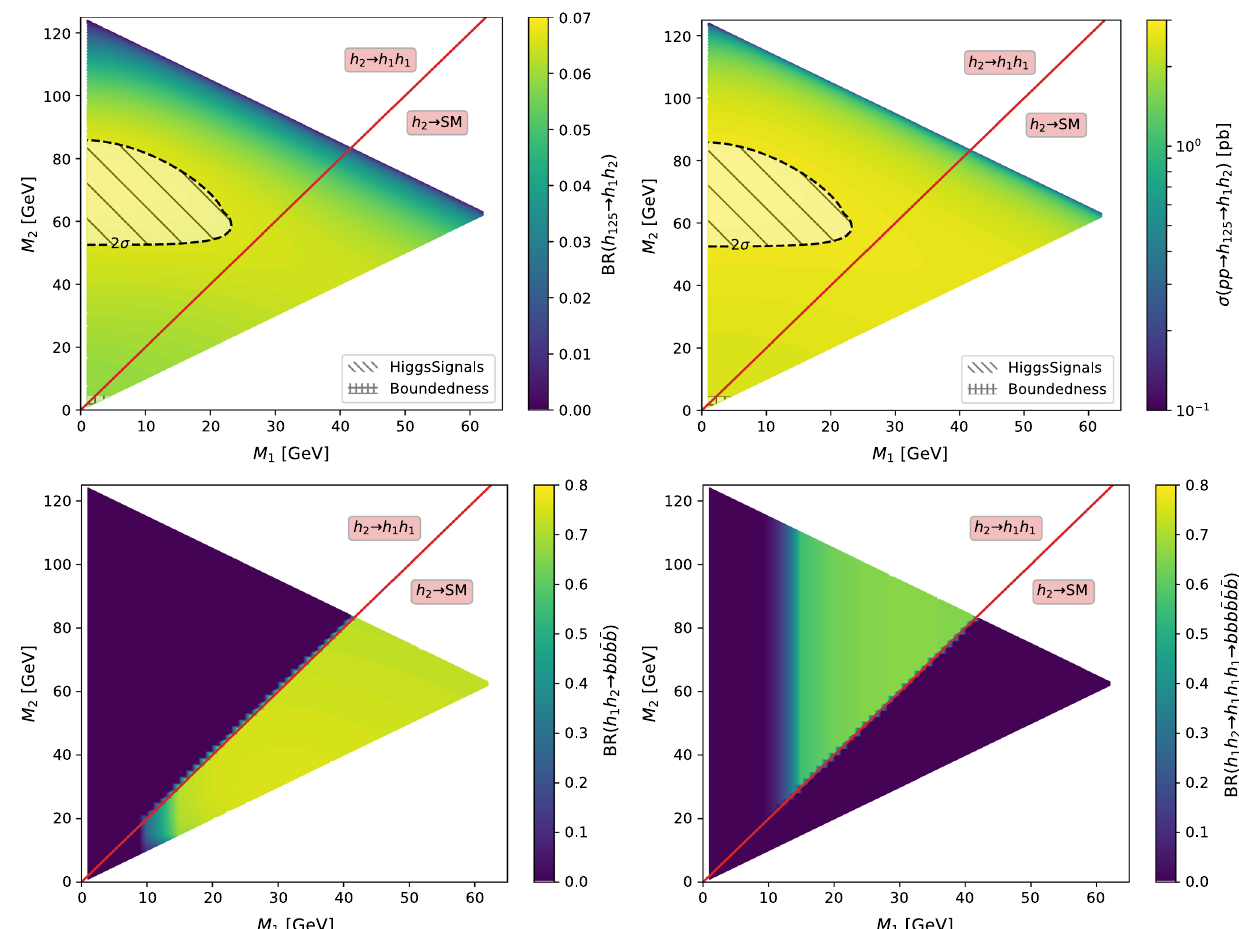
Fig. 6 Benchmark plane BP1 for the decay signature h 125 → h 1 h 2 with h 125 ≡ h 3 , defined in the ( M 1 , M 2 ) plane. The color code shows BR ( h 3 → h 1 h 2 ) (top left panel) and the 13 TeV LHC signal rate for pp → h 3 → h 1 h 2 (top right panel). The red line separates the